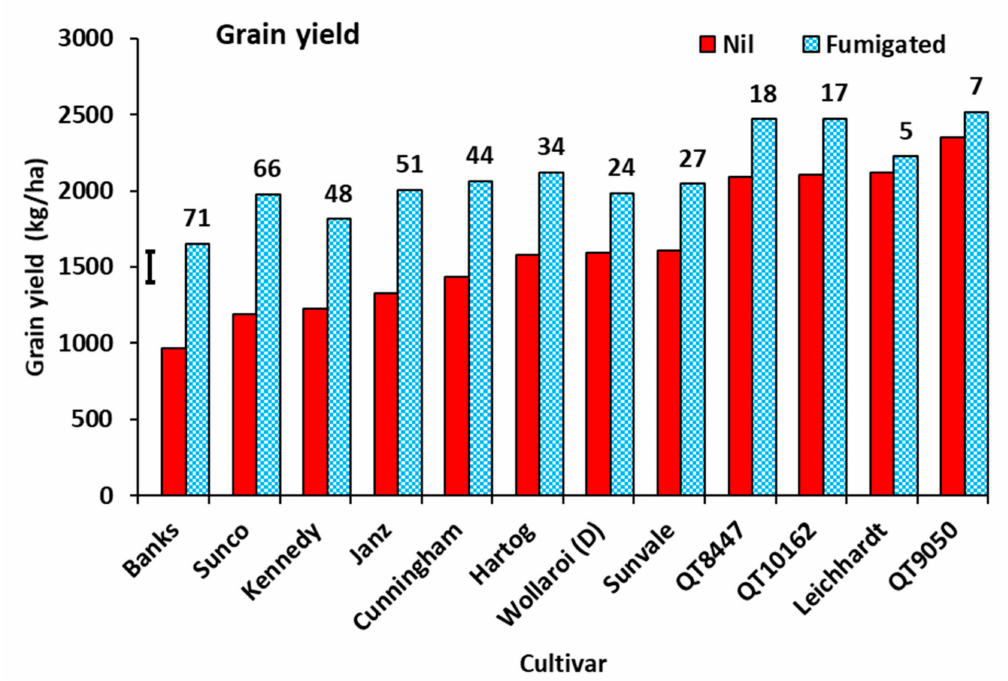
Figure 9. Grain yield of wheat and durum cultivars in response to soil fumigation with methyl bromide in Experiment 3. The graph is presented with cultivars in ascending order of grain yield from nil treatment. Bar marker represents l.s.d. ( p = 0.05) for fumigation x cultivar interaction. (D) signifies a durum wheat cultivar. Values above bars are the percentage response to